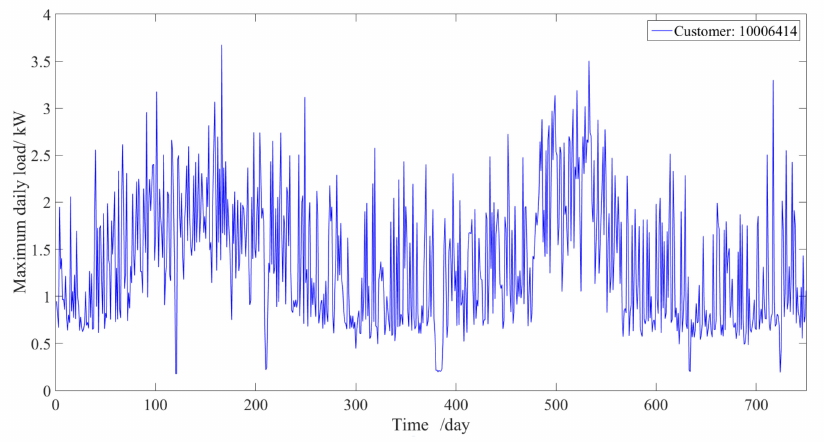
Figure 1. The maximum daily loads of the customer numbered as 10006414 from February 2012 to March